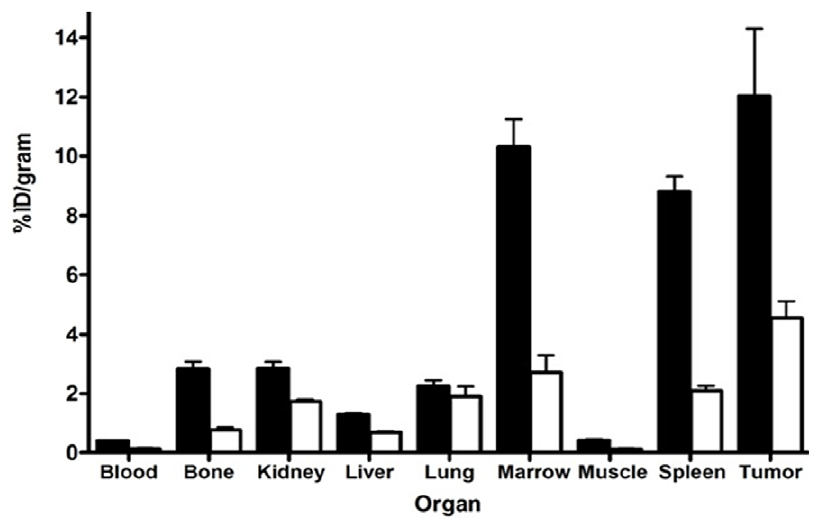
Figure 3. Tissue biodistribution of 64 Cu-CB-TE1A1P-LLP2A in 5TGM1 s.c. tumor mice. Biodistribution of 64 Cu-CB-TE1A1P-LLP2A in 5TGM1 s.c. tumor mice (black bars). The open bars represent biodistribution in the presence of non-radioactive blocking agent ( , 200 fold excess LLP2A). Mice were injected with 64 Cu-CB-TE1A1P-LLP2A (0.01 m g, 0.2 MBq, SA: 37 MBq/ m g) and sacrificed at 2 h post injection. N=4 mice/group.